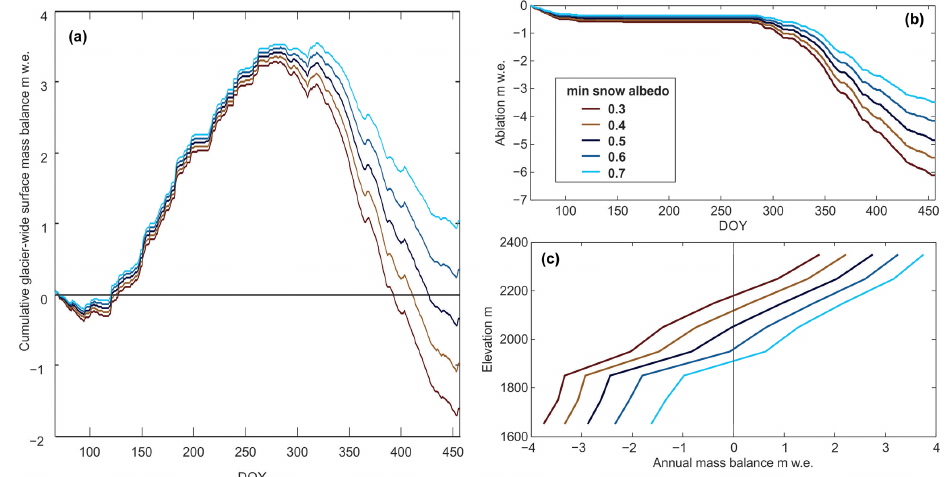
Figure 9. Sensitivity of Alerce surface mass balance to change in albedo of aged snow. (a) Cumulative surface mass balance, (b) cumulative melt, and (c) mass balance gradient of Alerce Glacier for the different α min